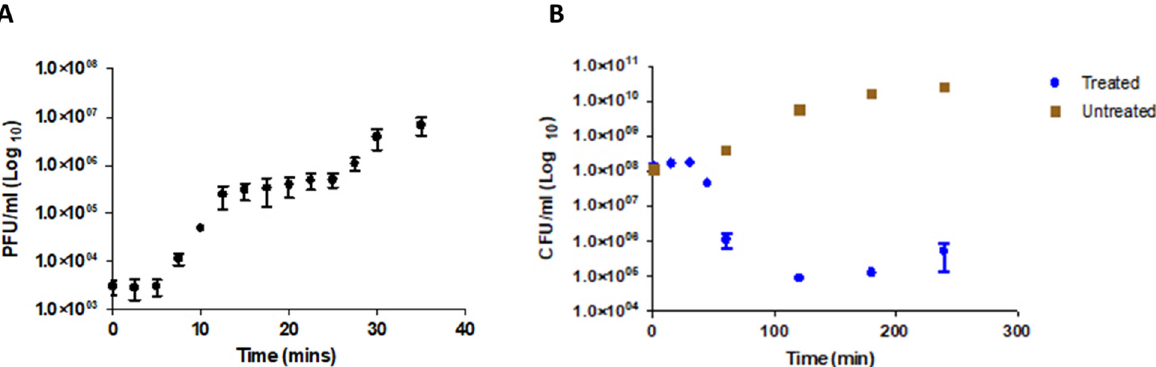
Figure 2. ( A ) One-step growth curve of Proteus _virus_309 and ( B ) lysis of P. mirabilis B16 culture following infection with phage 309 (MOI of 0.01). Lysis was followed over 4 h.